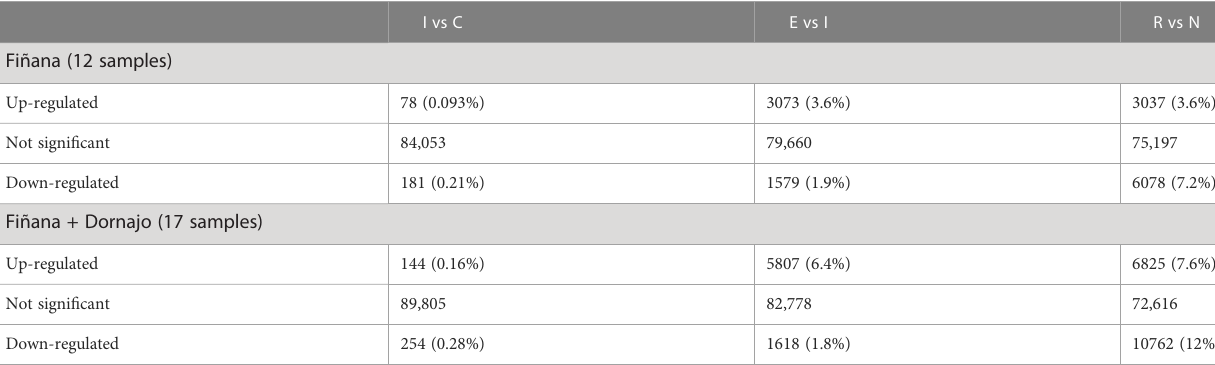
TABLE 1 Differentially expressed genes between treatments/responses